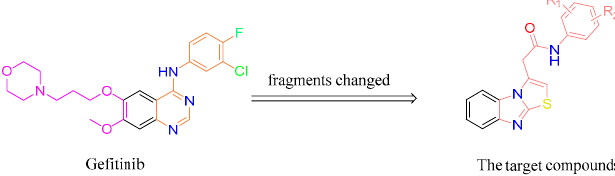
Figure 3. The design of the target compounds based on the structure of gefitinib.